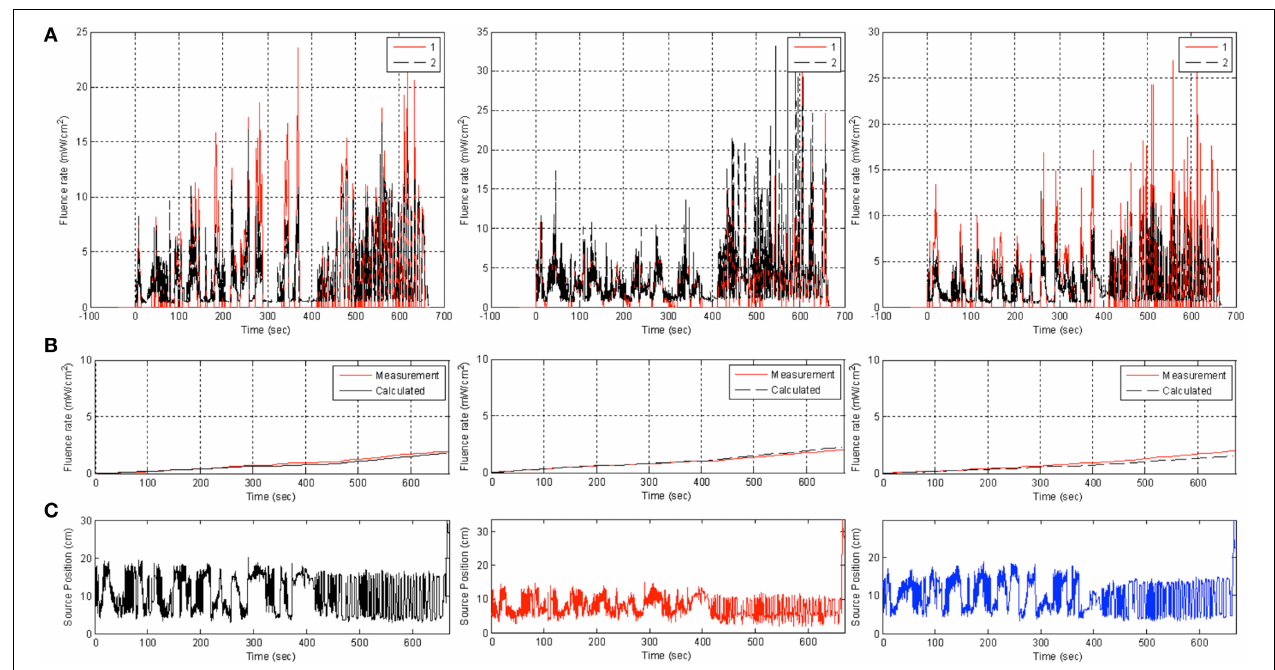
FIGURE 9 | Comparison of measurement (red) and uncorrected calculation (black) using Equation (6) (red) in phantom at three detector locations (from left to right: 1, 2, 3) for light fluence rate (top row, A), cumulative light fluence (middle row, B), and the value of r to each detector (bottom row, C).